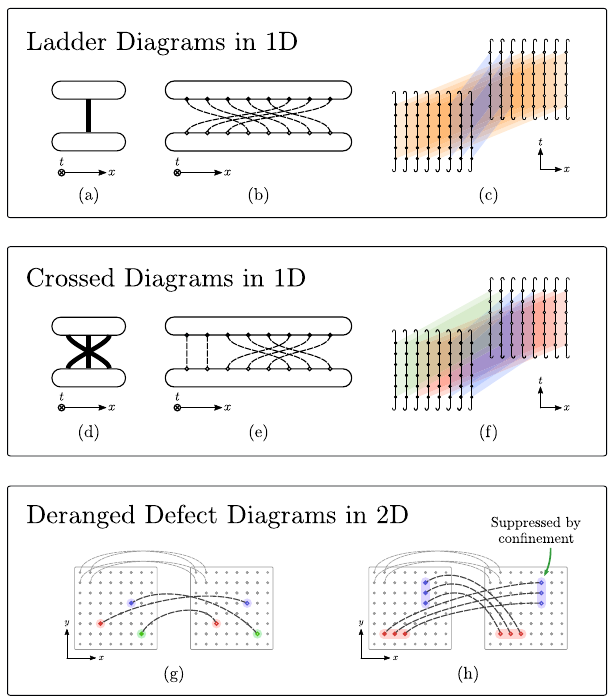
Fig.3|Many-bodyFeynmandiagramsofSFFofMBQCsystemswithspace-time translational invariance. a A representation of the set of ladder diagrams